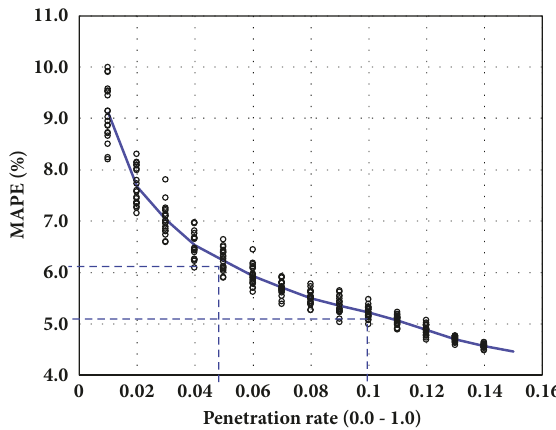
Figure 13: Predictability according to penetration